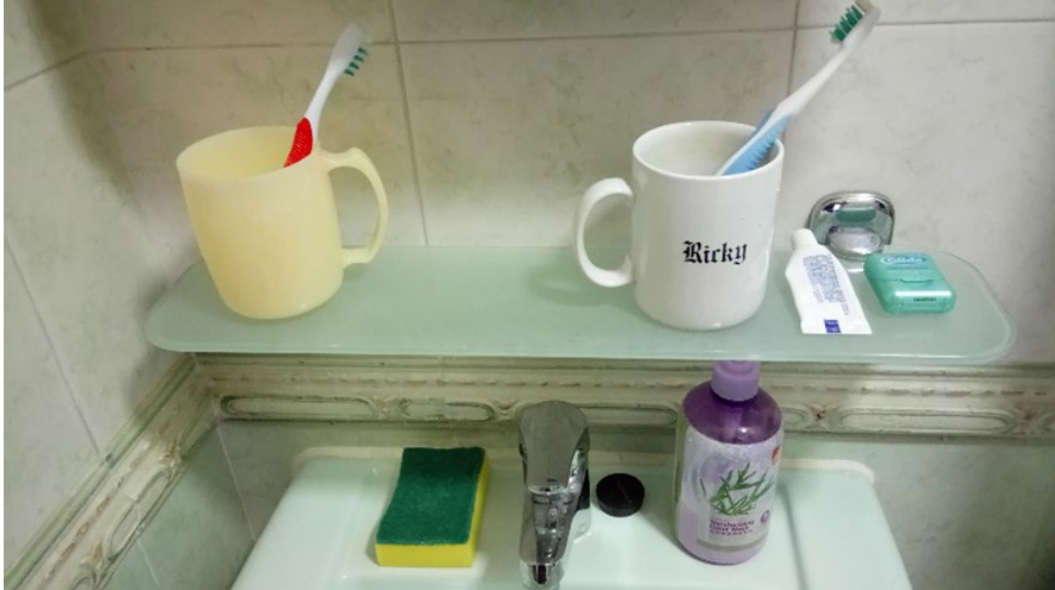
Figure 2. A tidy oral hygiene practice station with label on the elderly’s rinsing cup.